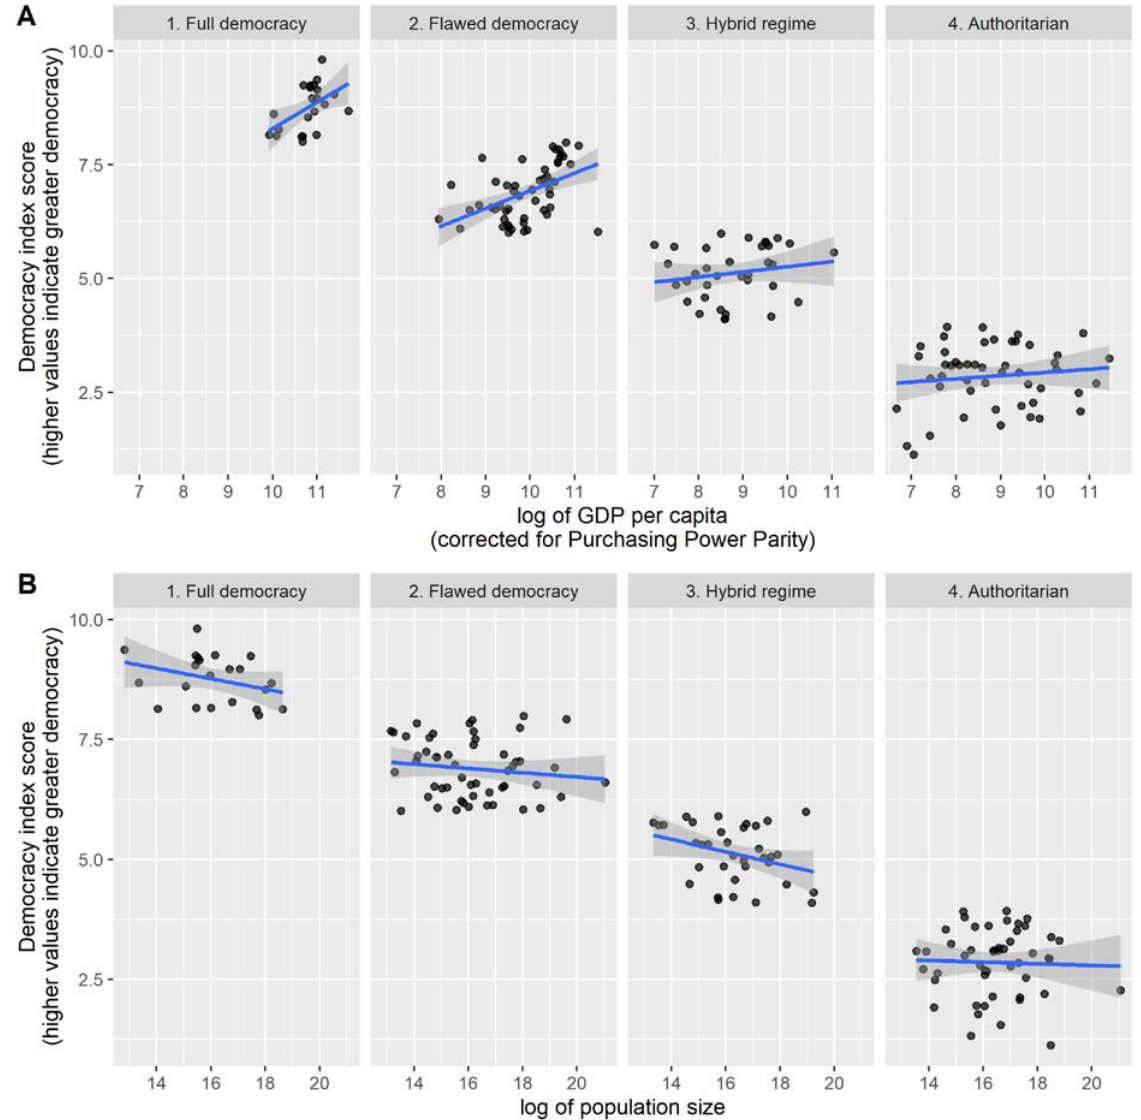
Figure 2: Relationship of the Democracy Index Score (DIS) (each point represents a country) with the logarithm of the country’s Growth Domestic Product per capita, corrected for purchasing power parity (A) and the logarithm of the country’s population size (B). Within each regime type, a higher democracy index is more likely when GDP per capita is high (LMM: 0.19 ± 0.06, t = 2.990, p < 0.01) (Fig. 1A). There is also a tendency for countries with smaller populations to be more democratic (LMM: -0.08 ± 0.05, t =